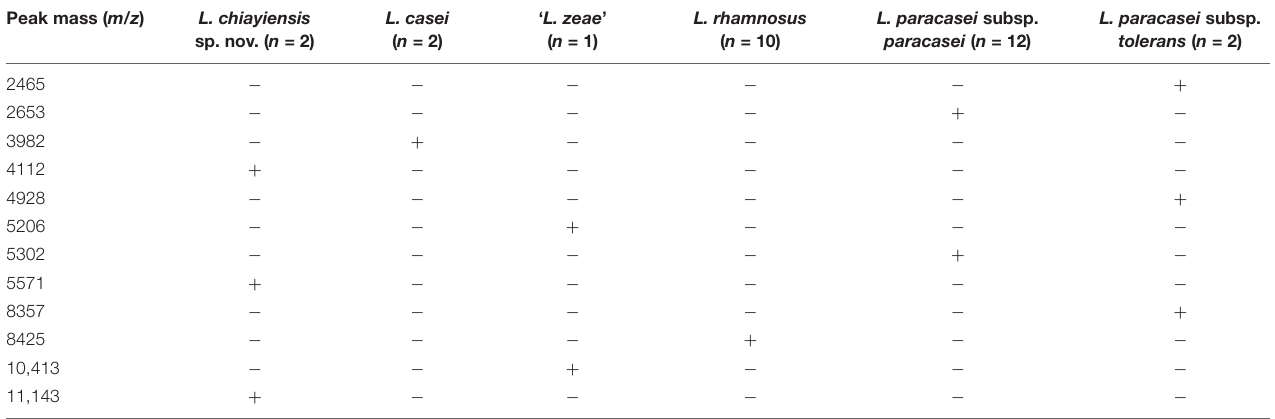
FIGURE 2 | Dendrogram derived from UPGMA cluster analysis of MALDI-TOF MS spectra in the 2000–9500 m/z region (224 peaks) of strains in the L. casei group. Bootstrap values (%) based on 1000 replicates are given at the nodes. Bar, proportion of different peaks. TABLE 1 | Species- and subspecies-specific MALDI-TOF MS peaks used for differentiation of the Lactobacillus casei group. Peak mass ( m/z